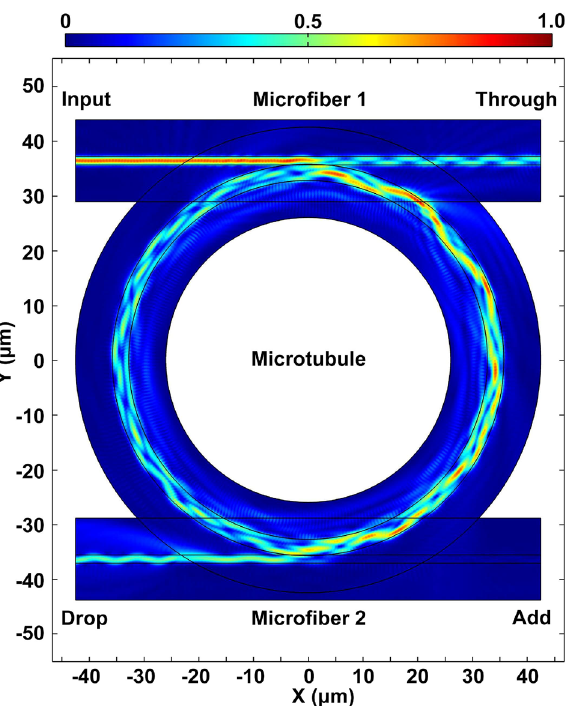
Figure 4: Simulated electric field distribution of the double-fiber-coupled microtubule